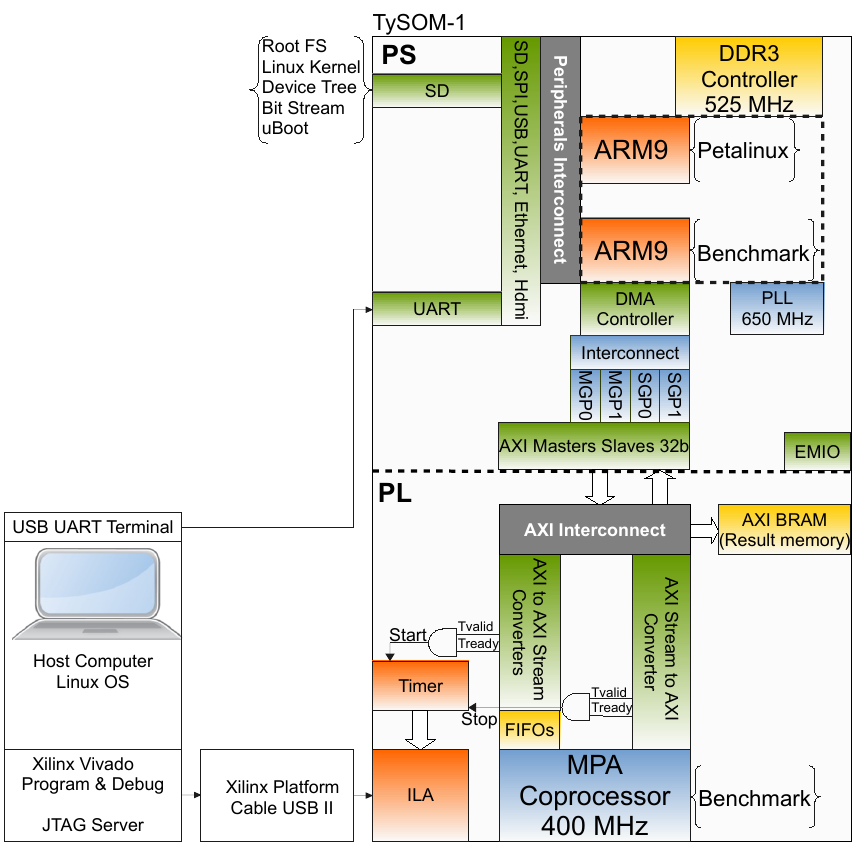
Figure 12. Benchmarking setup for MPA coprocessor.